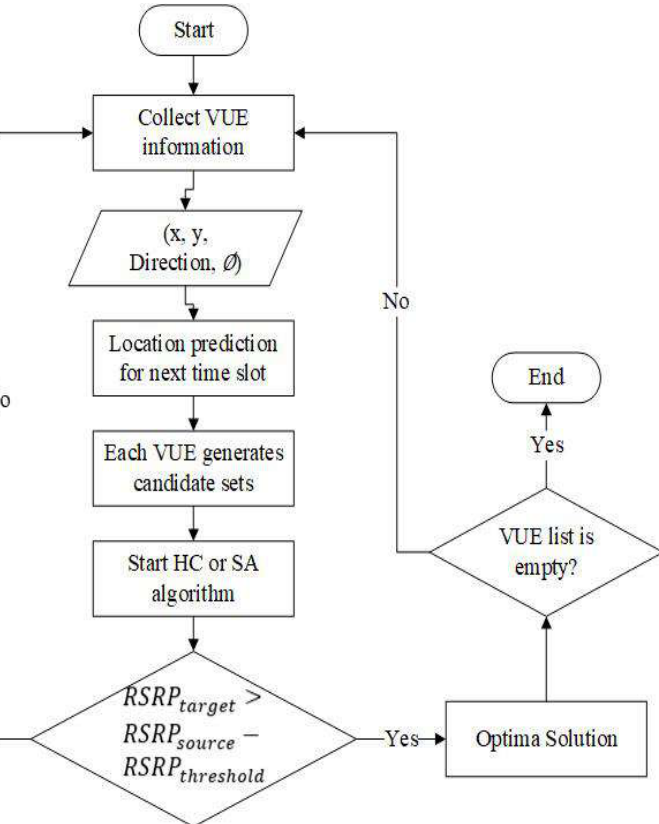
Figure 2. The flowchart of our proposed